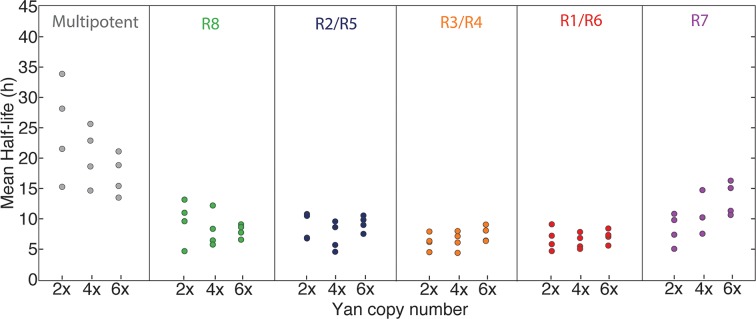
Yan protein half-life is largely unaffected by yan gene copy number.Exponential decay of Yan-YFP levels. Note the robustness of Yan-YFP half-lives across replicates and yan gene copy number. Note also how half-lives are nearly twice as long for progenitor cells versus photoreceptor neurons.